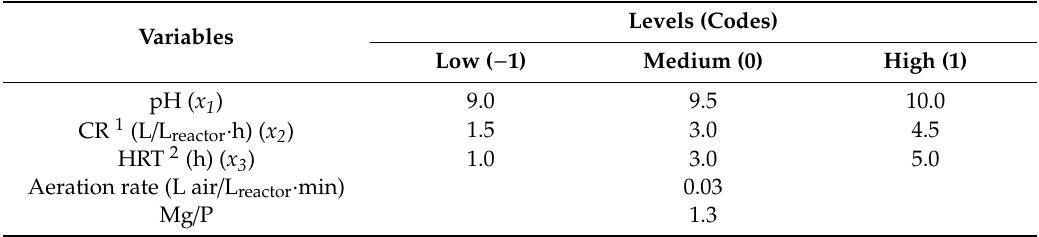
Table 2. Operating conditions of optimization of the recovery process.